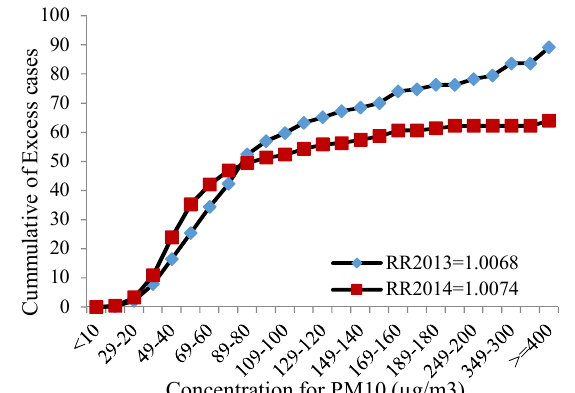
Fig. 5. Estimated cumulative number of mortality related to particles with diameter of less than 10 microns in Ilam Air Q model in the years 2013 and 2014